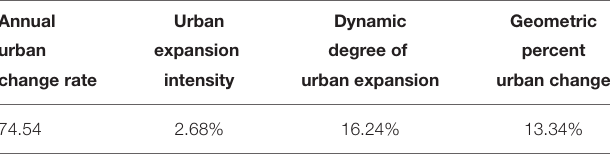
TABLE 6 | Analysis methods for quantifying urban expansion over the period of 2012–2016.